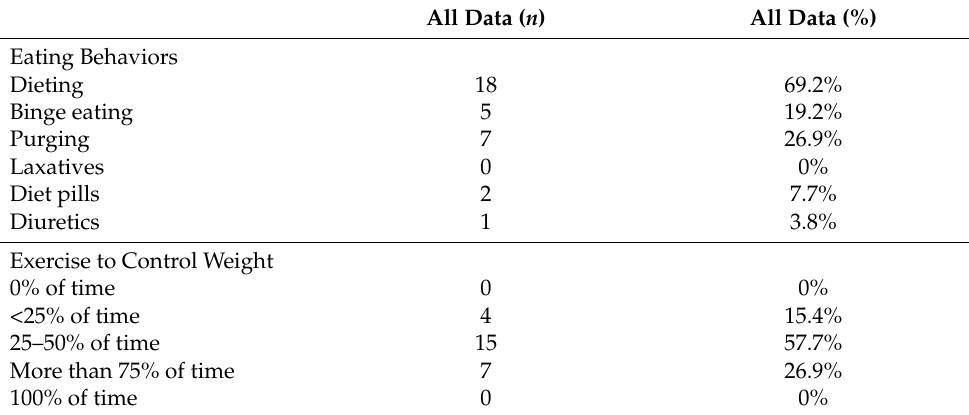
Table 4. Eating disorder pathogenic behaviors (from EDI-3 SC) among dancers ( n = 28). All Data ( n )